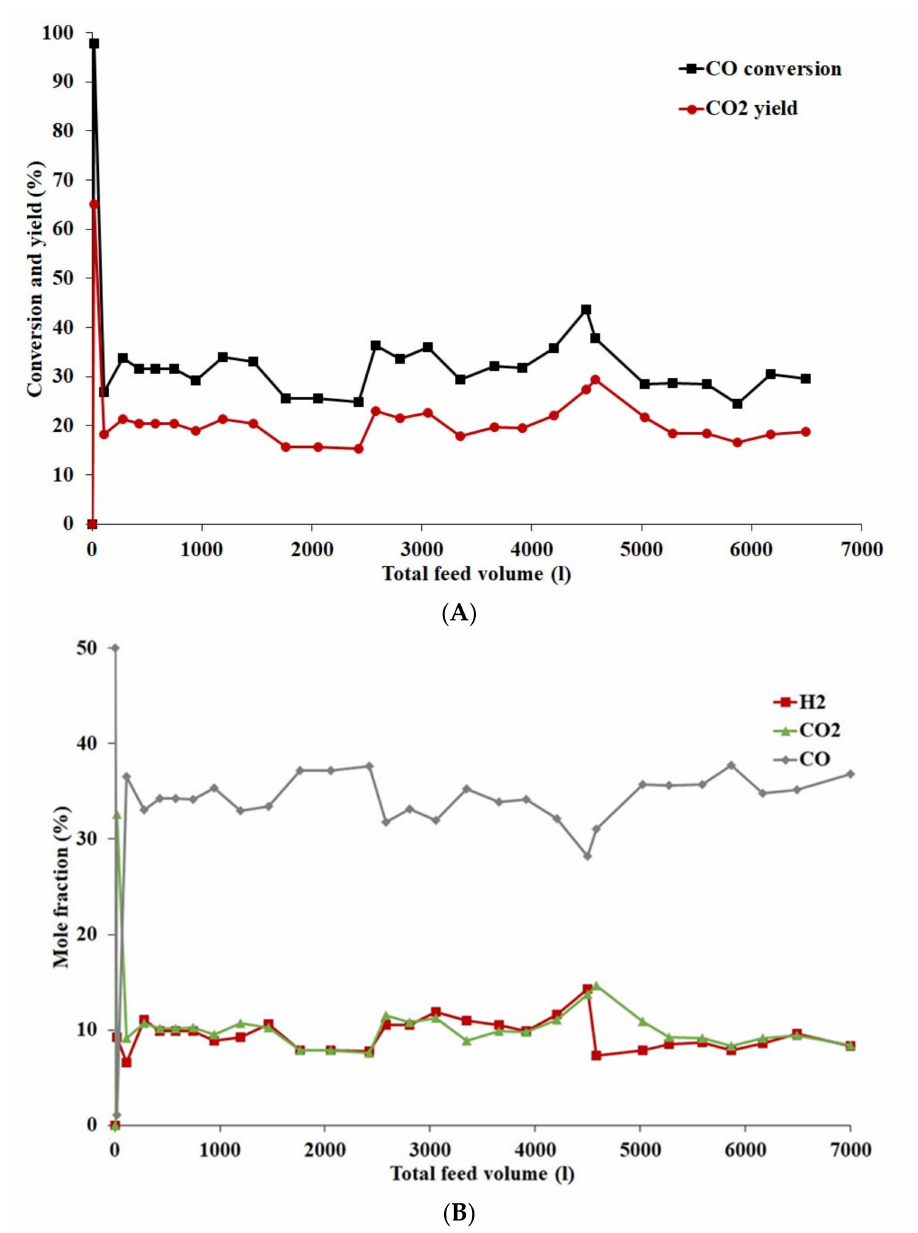
Figure 19. Catalytic tests with feed gas mixture 2 (50 mole% CO, 0.4 mole% H 2 S, balance N 2 ) at pressure 0.5 MPa, over a Co-based catalyst (9.6 wt%): ( A )—CO conversion and CO 2 yield; ( B )— composition of the gas